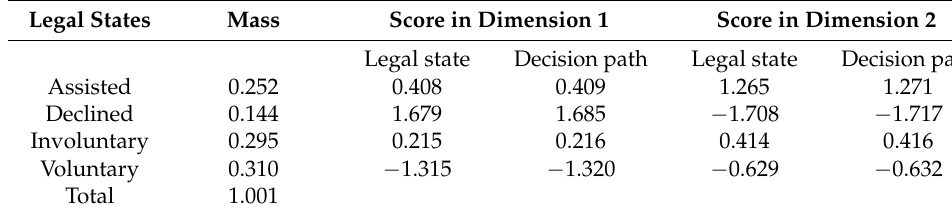
Table 6. Scores of the legal states and decision paths in the correspondence analysis 1 .